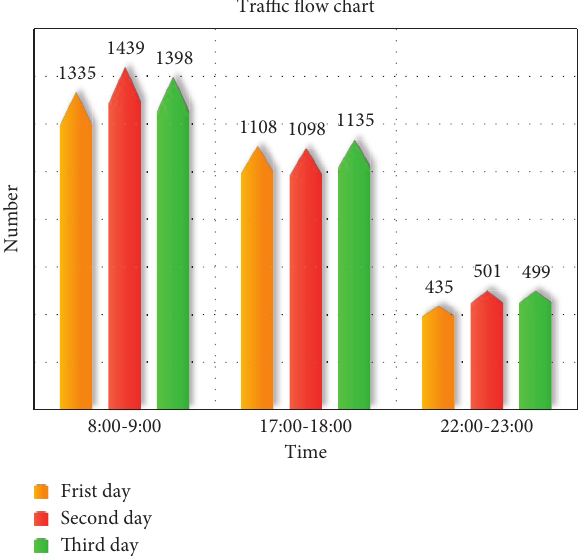
Figure 3: Traffic flow statistics for different periods. Table 2: Using the ground induction coil+video detection mode at 12 noon.